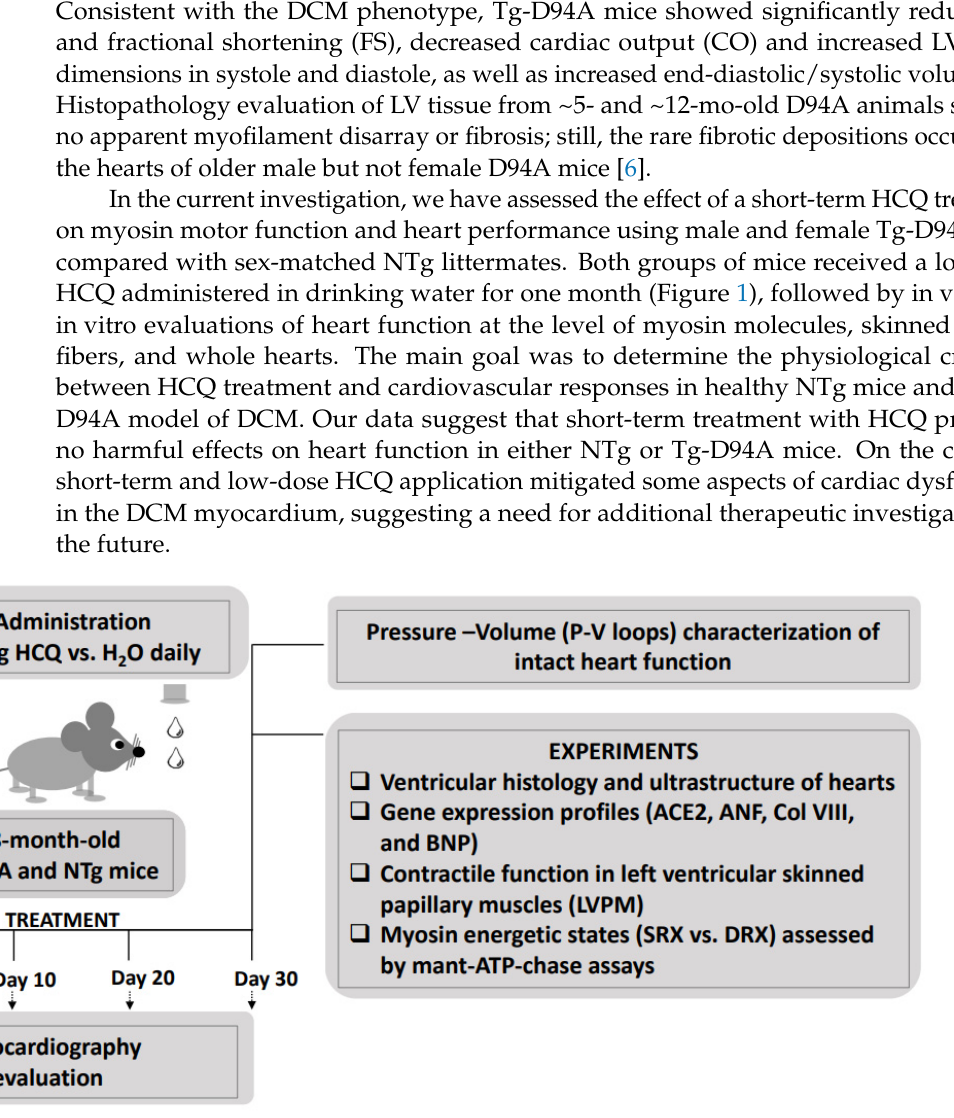
Figure 1. Schematic representation of the HCQ- vs. placebo (H 2 O) experimental design and the assessment of heart function in Tg-D94A vs. NTg mice. 5–8-mo-old Tg-D94A and NTg mice of both sexes were designated for HCQ (N o = 16) vs. placebo (N o = 16) treatment. Female and male mice were housed separately from each other, with 2–4 females and 1–5 males placed in one cage. After 30 days of treatment, the animals were evaluated for changes in the in vivo heart function, heart morphology, ultrastructure, and sarcomeric contractile and energetic